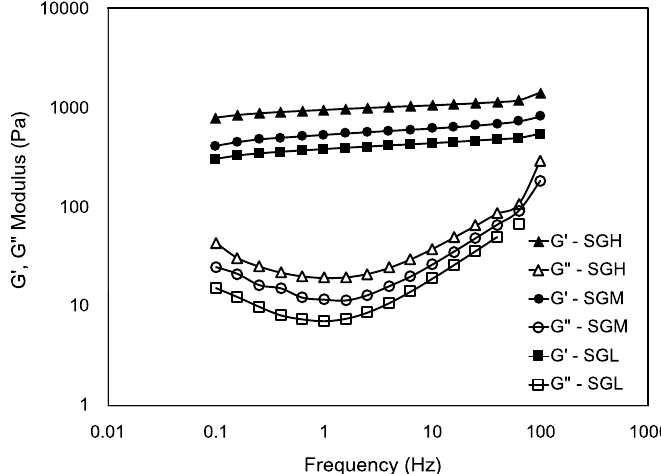
Figure 6. Oscillatory frequency sweep of salmon gelatin with controlled molecular weight. All samples tested 5 °C below the gelling temperature assessed by rheology.